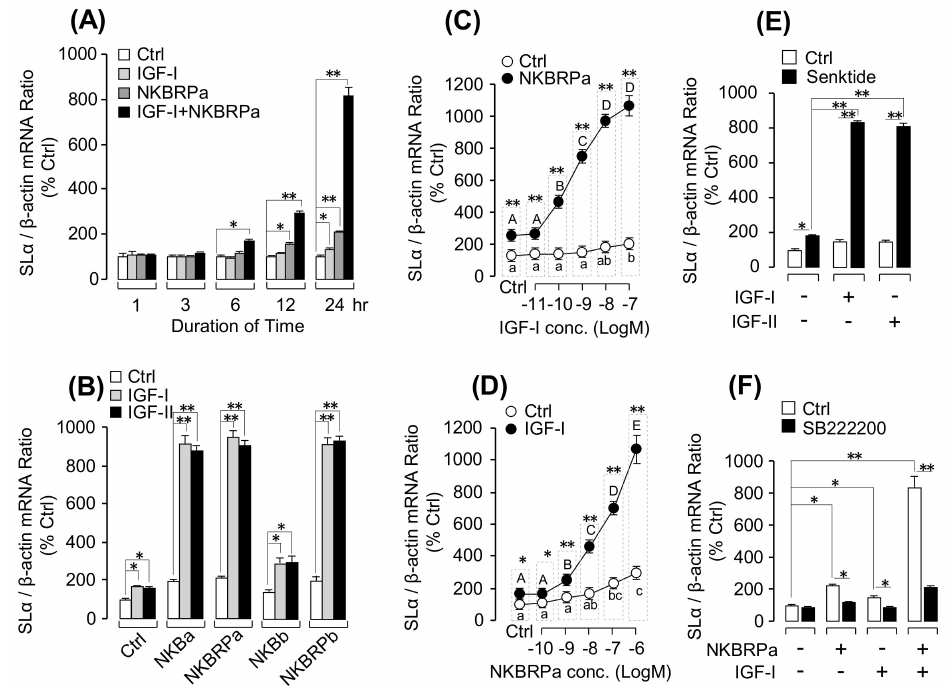
Figure 4. Potentiating e ff ects of IGFs on TAC3 gene product-induced SL α mRNA expression in